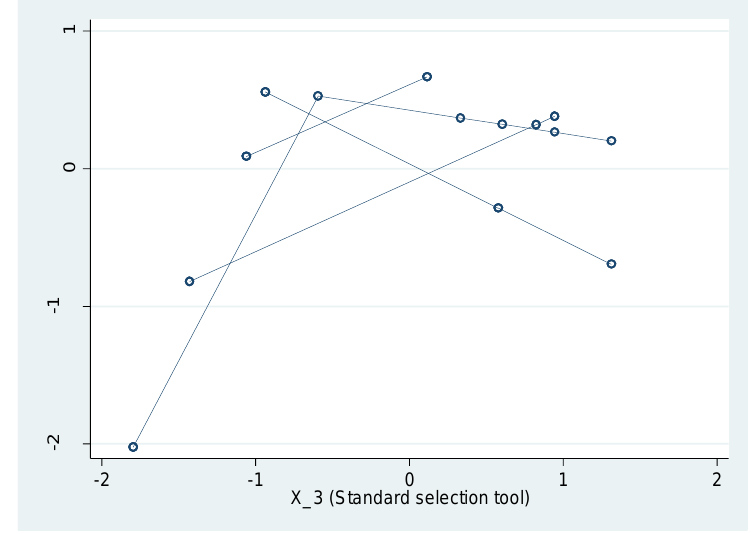
Figure 4: Random Slopes of Standard Selection